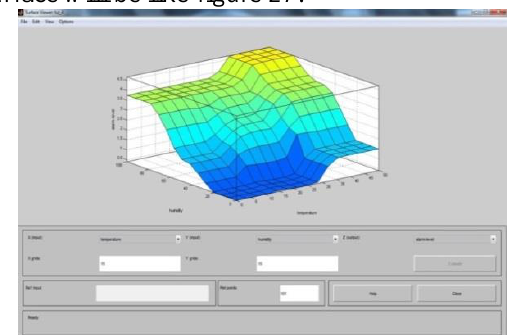
Figure 27. Surface view of FIS and summarization of effects of temperature and humidity (inputs) on alarm level